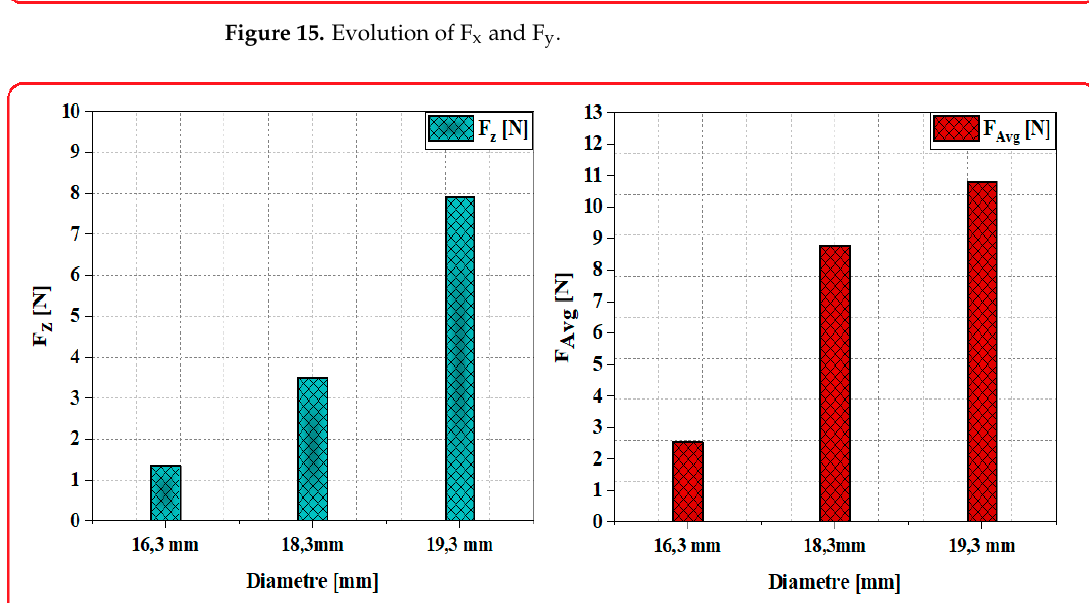
Figure 16. Evolution of F z and F Avg .